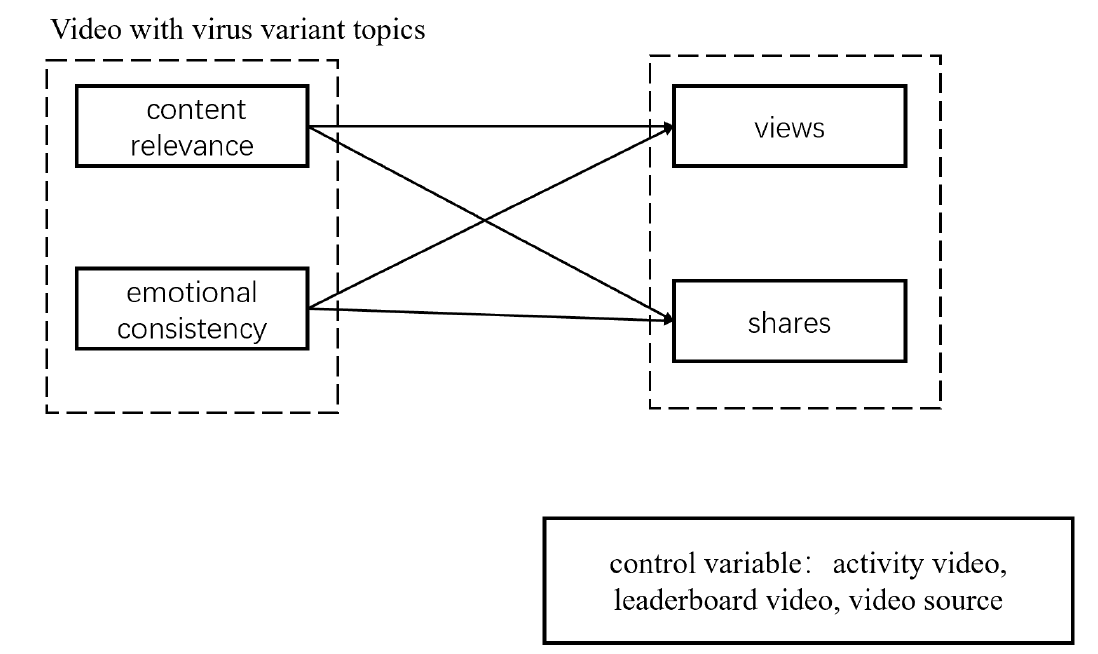
Figure 1. Research